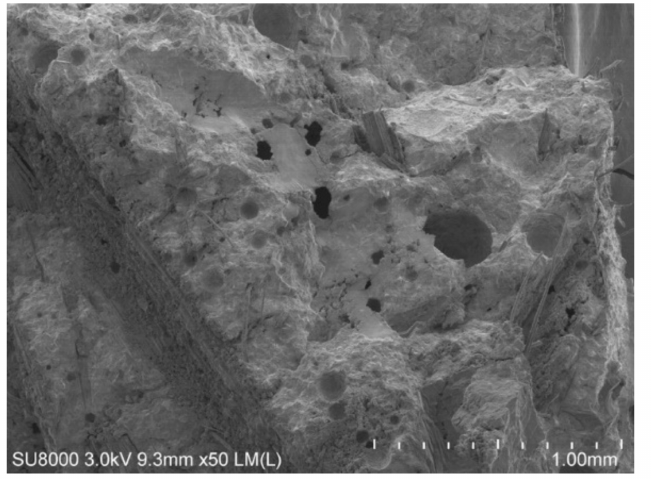
Figure 11. SEM images of fracture surface of fiber treated by aluminate